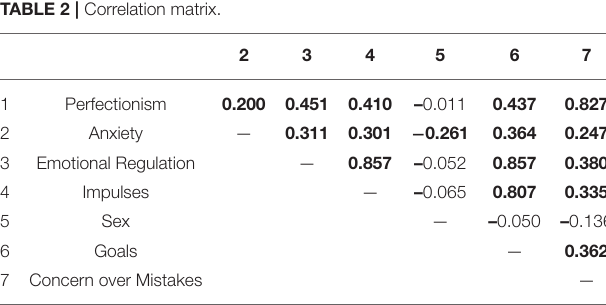
TABLE 2 | Correlation